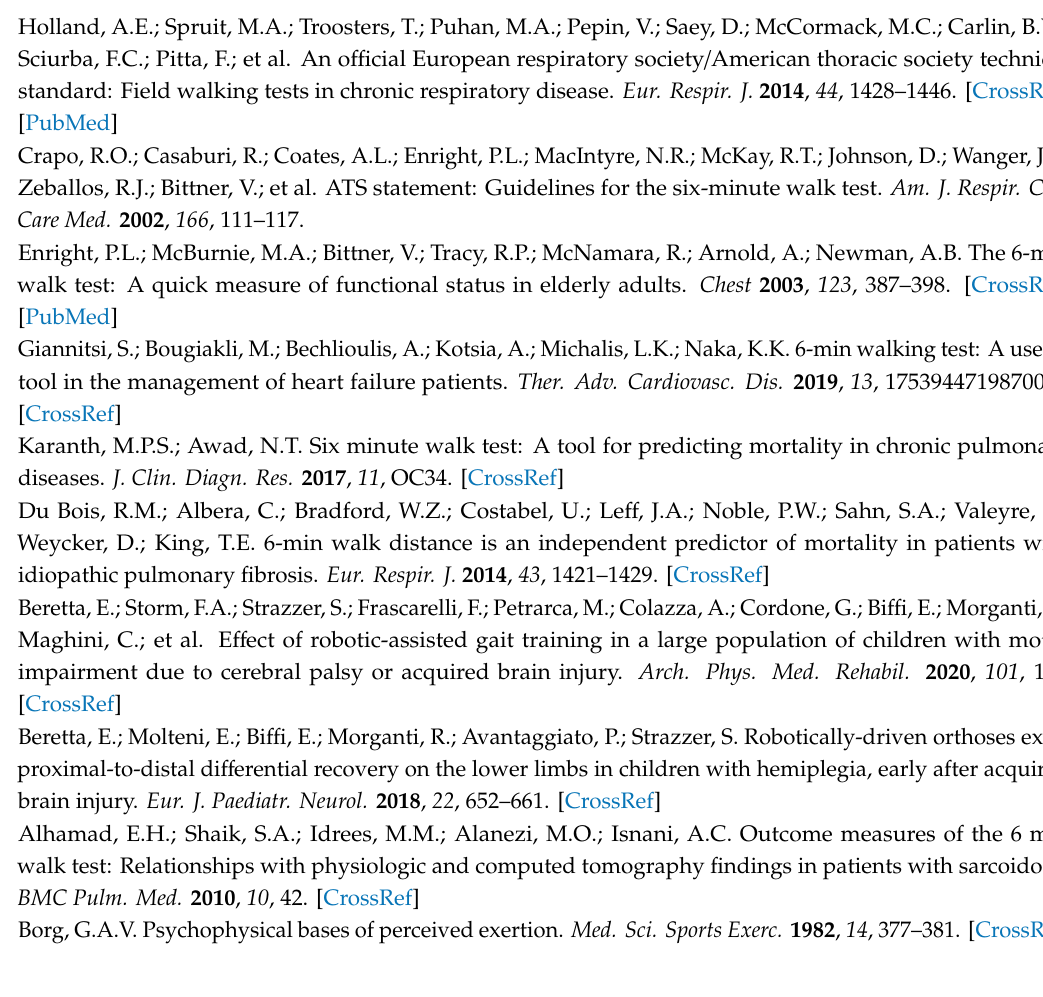
Table S1: Detailed results of the quality assessment conducted by each rater on the articles included in the systematic